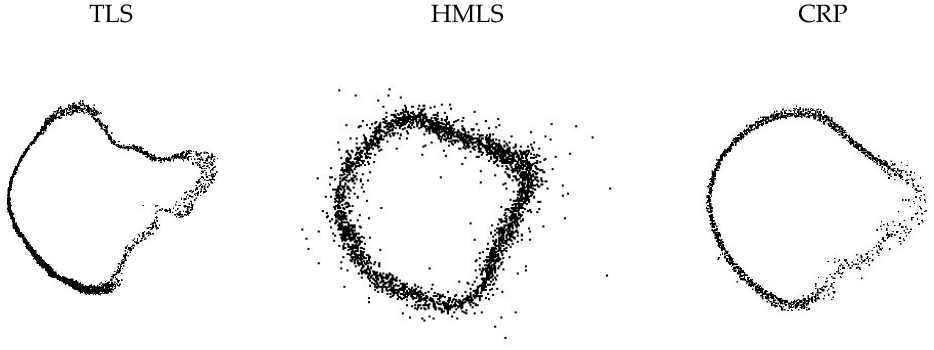
Figure 10. The irregular shape of trunk cross sections, visualized on representative trees.